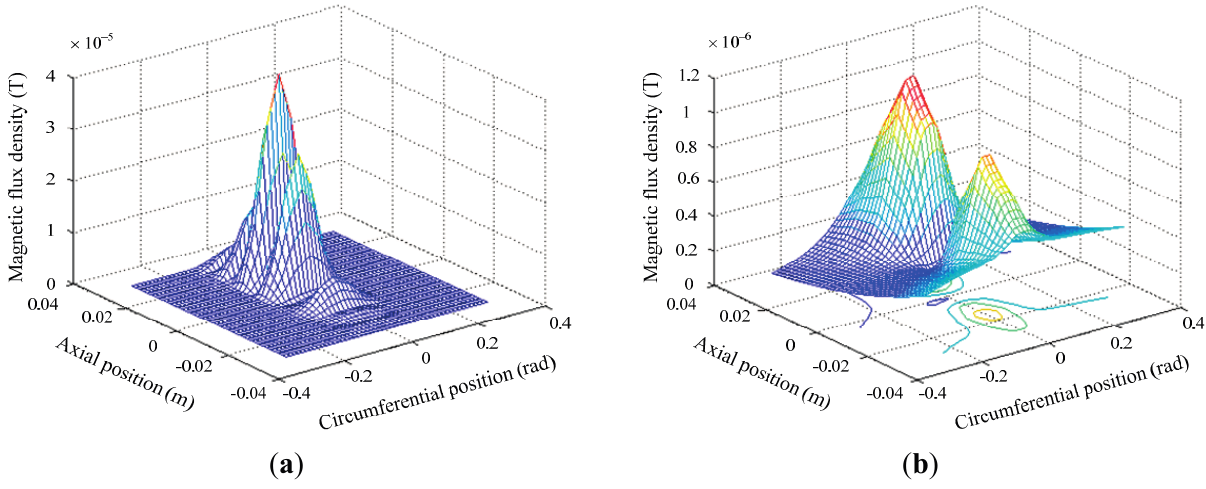
Figure 5. Perturbation field caused by ( a ) Circumferential crack; ( b ) Axial crack.